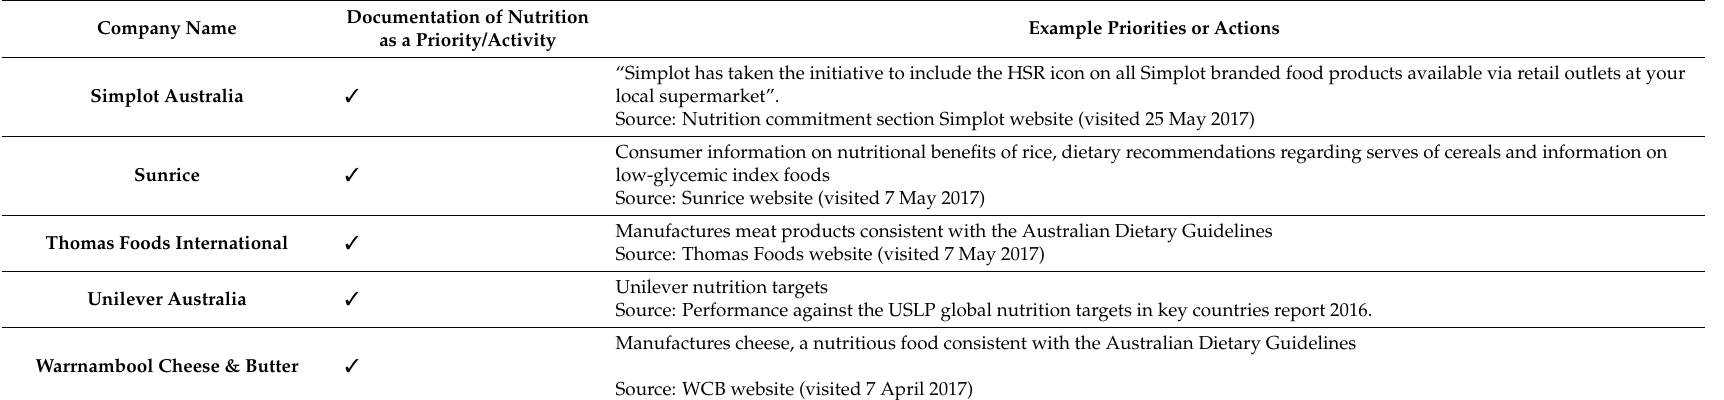
Table Key: Obtained a tick (Reformulation concerning nutrients, not including sodium, such as fat, sugar, kilojoules, protein, fibre, vitamins, minerals; Development of healthier-product lines; Providing consumer nutrition information, including participation in the Health Star Rating; Producing a core food “healthy” product consistent with the Australian Dietary Guidelines; Marketing standards (i.e., advertising to children)); Did not obtain a tick (Food safety, quality assurance and allergen compliance; Reformulation concerning non-nutrient components (i.e., artificial colours/flavours, organic health claims); Manufactured only discretionary